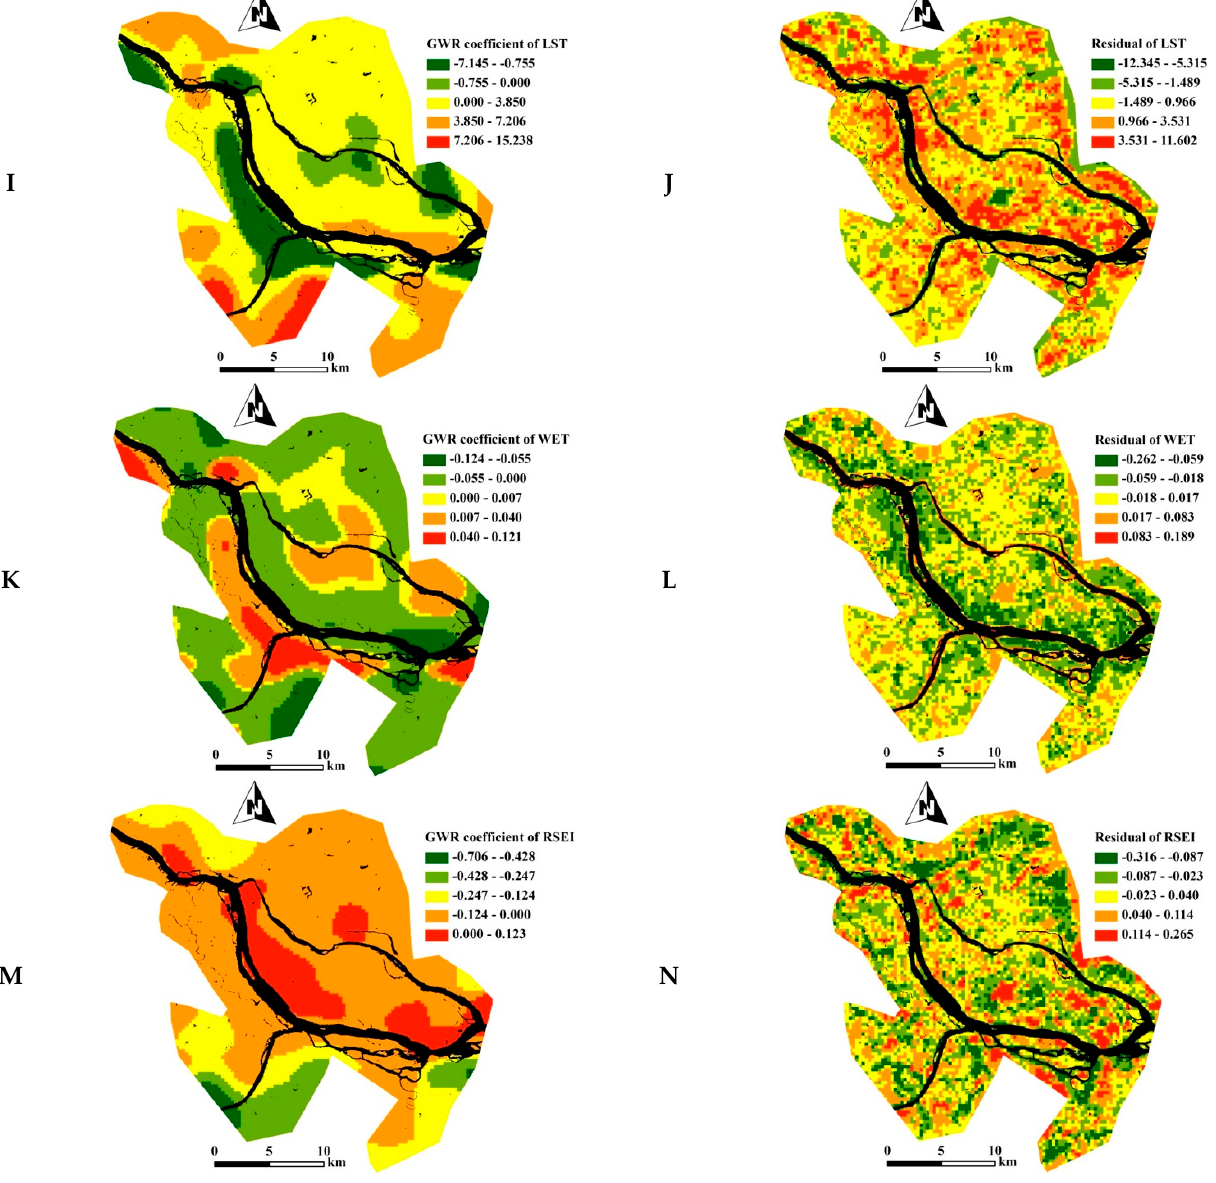
Figure 4. Geographically weighted regression (GWR) coefficient and residual of different ecoenvi- ronmental indicators against kernel density of roads (KDR). ( A , B ) Normalized difference vegetation index (NDVI) against KDR; ( C , D ) index-based built-up index (IBI) against KDR; ( E , F ) soil index (SI) against KDR; ( G , H ) normalized differential build-up and bare soil index (NDBSI) against KDR; ( I , J ) land surface temperature (LST) against KDR; ( K , L ) land surface moisture (LSM) against KDR; ( M , N ) remote-sensing-based ecological index (RSEI) against KDR.